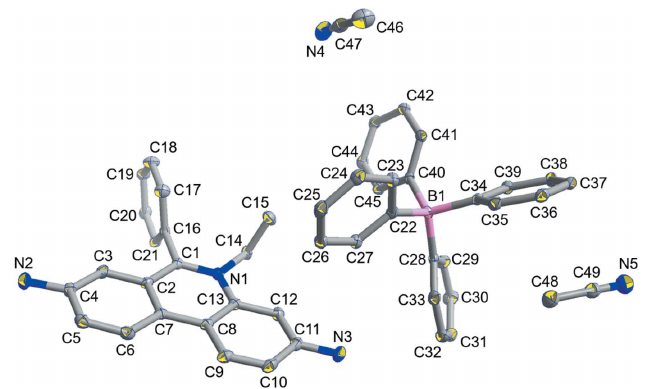
Figure 1 The molecular structure of (C 21 H 20 N 3 ){B(C 6 H 5 ) 4 } (cid:2) 2CH 3 CN with displa- cement ellipsoids drawn at the 50% probability level. Hydrogen atoms are omitted for clarity.